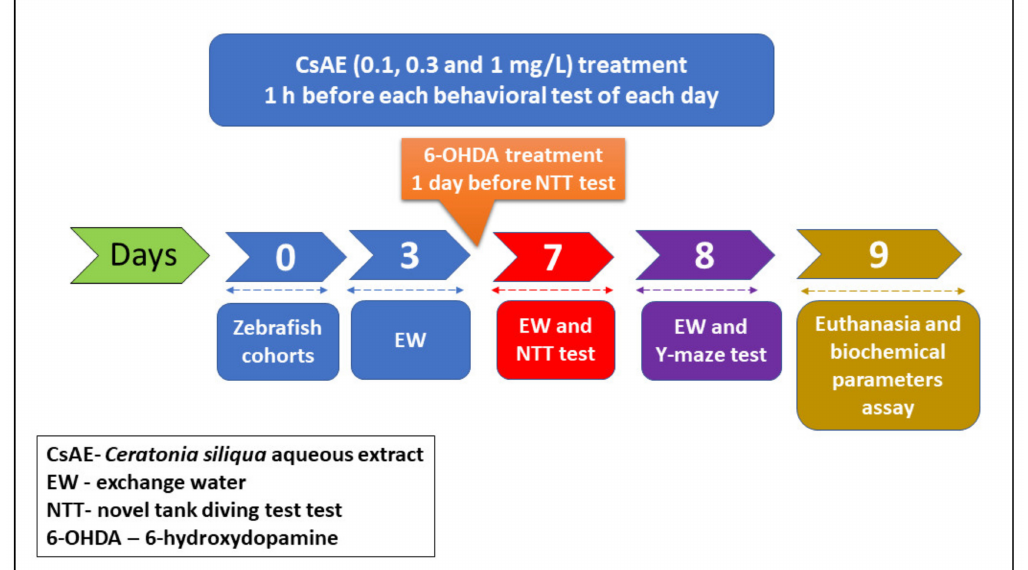
Figure 1. Schematic representation of the experimental